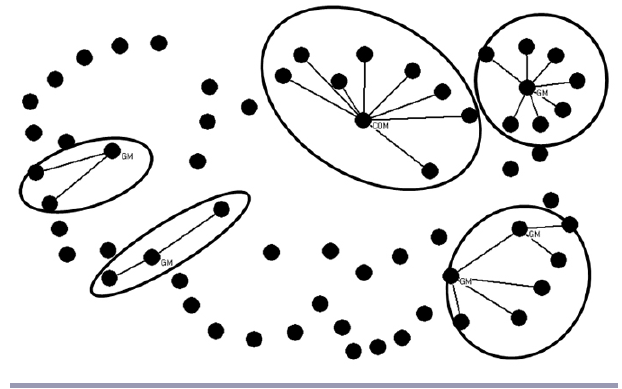
Fig. 5 . Landcare Group A interest clusters - vegetation.